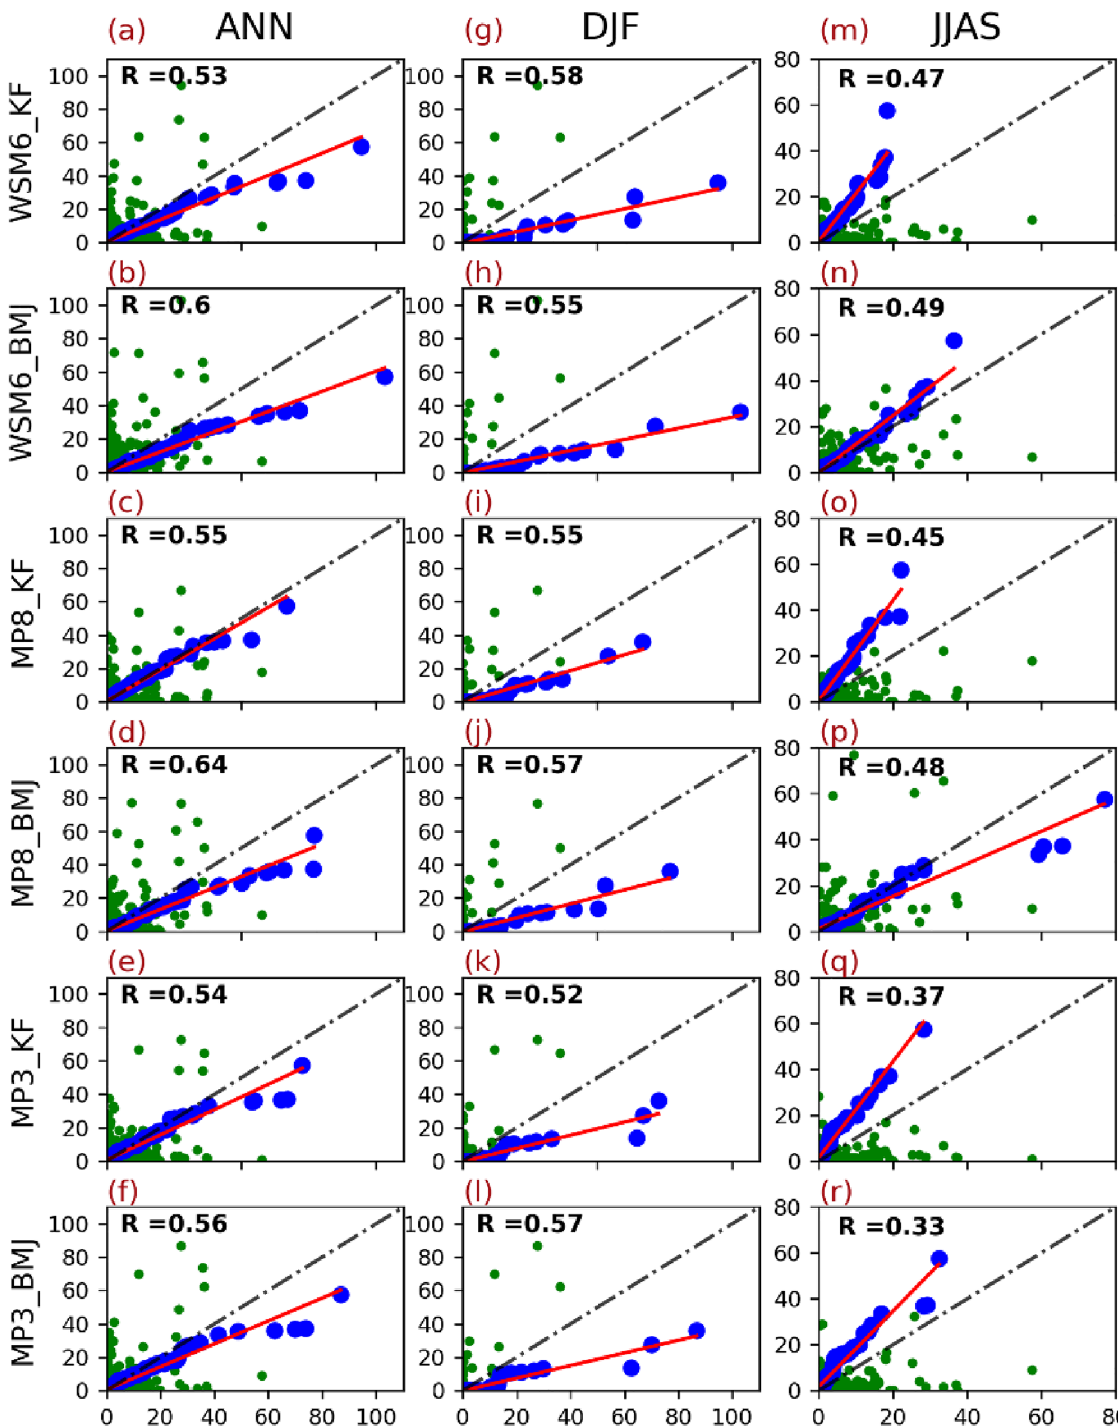
Figure 5. Quantile Quantile plot (Q–Q plot) between WRF simulated precipitation and Aphrodite for 2003. The WRF simulated experiments (WSM6_KF, WSM6_BMJ, MP8_KF, MP8_BMJ, MP3_KF, and MP3_BMJ) are plotted against Aphrodite precipitation for ANN ( a ), DJF ( b ), and JJAS ( c ). The blue dots are quantile to quantile plot, whereas green dots are scatter plot. Red line is the regression line corresponding to the quantile–quantile plot. Black line is the reference